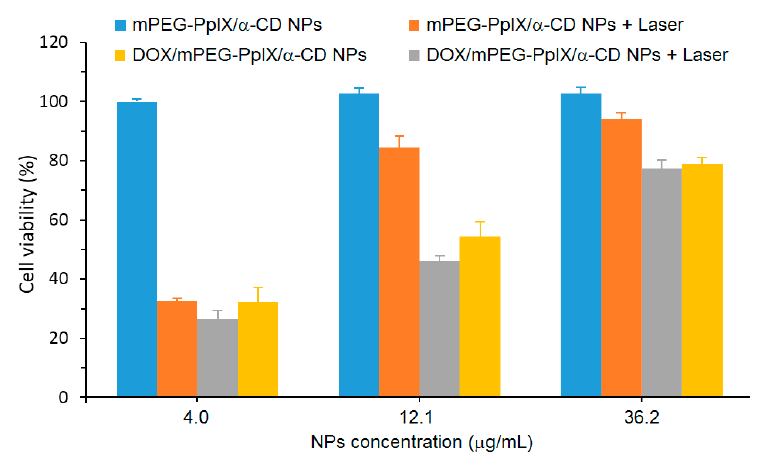
Figure 52. Cell viability of HepG2 cells incubated with mPEG-PpIX/ α -CD and DOX/mPEG-PpIX/ α -CD NPs before and after laser irradiation ( λ = 620–630 nm) at different NPs concentration. Adapted from Xu; Li; Cheng; Zhang; Cao; Gao; He [183].